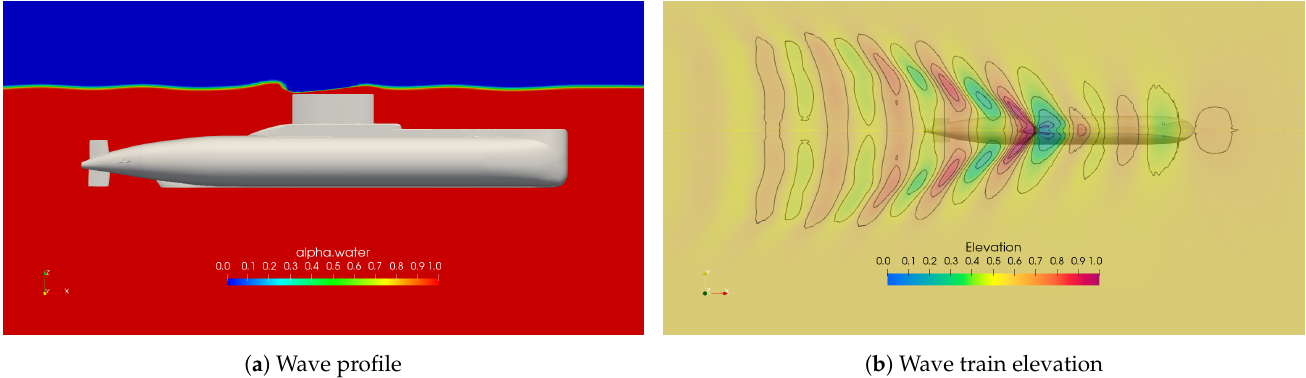
Figure 19. Wave train generated by Type 209/1300 submarine at H/D = 1.47 (condition 2—periscope depth) for Fr =